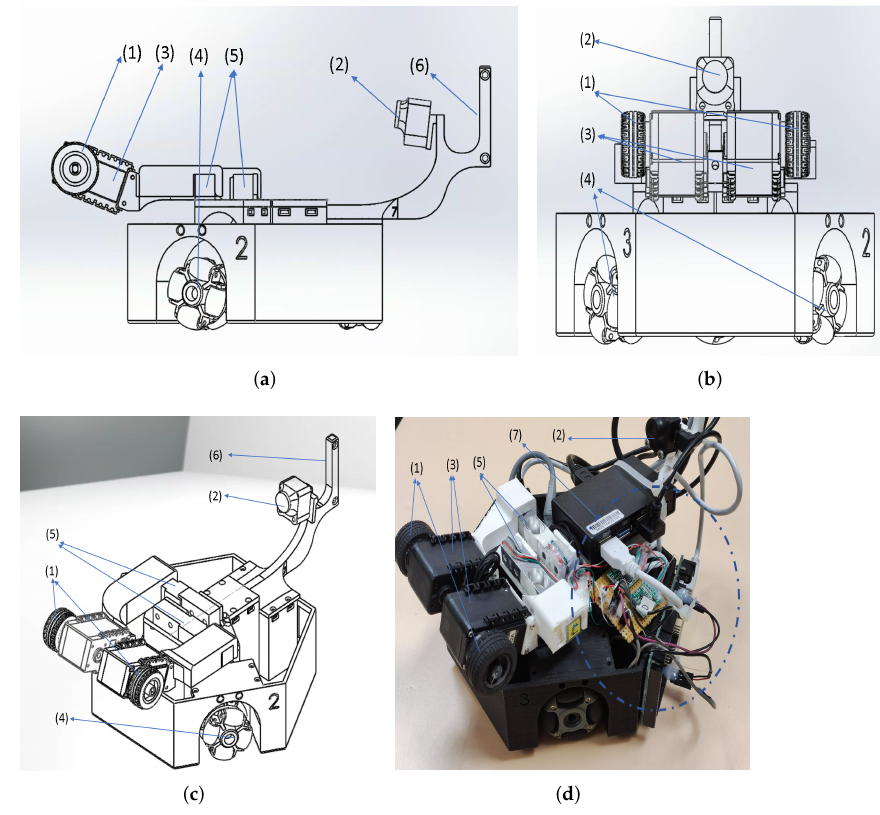
Figure 1. Robot Design: ( a ) side; ( b ) front; ( c ) corner; and ( d )